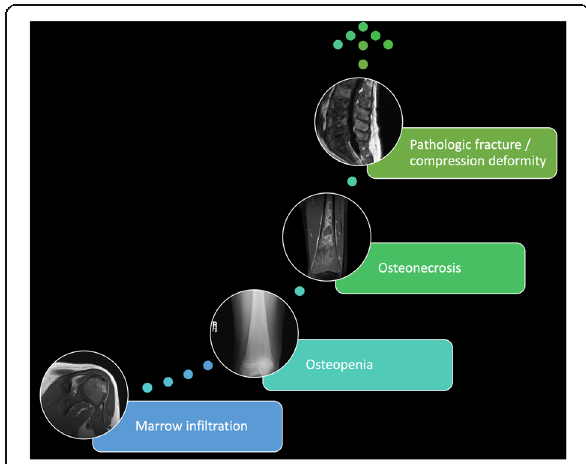
Fig. 6 Spectrum of musculoskeletal involvement in Gaucher disease. Nearly all type 1 Gaucher disease patients experience musculoskeletal manifestations ranging from marrow infiltration and osteopenia to pathologic fractures and compression deformities of the